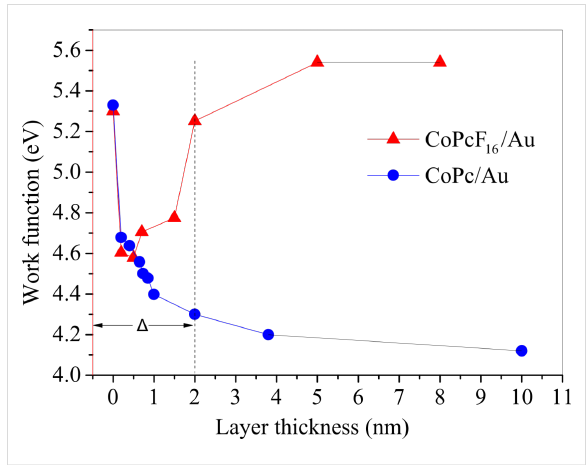
Figure 6: Energetic shift of the work function determined from the high binding energy cut-off in UPS spectra as a function of the film thick- ness for CoPcF 16 and CoPc on polycrystalline Au. The observed shift is attributed to the formation of an interfacial dipole Δ .